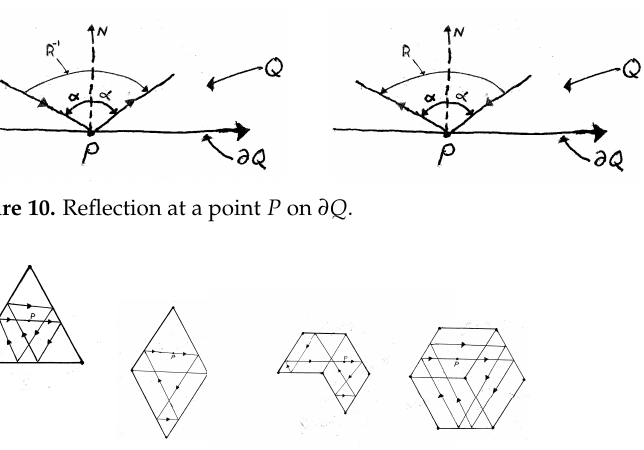
= Q ∪ S ( Q ) SR ( S ( Q )) . 1,1,1